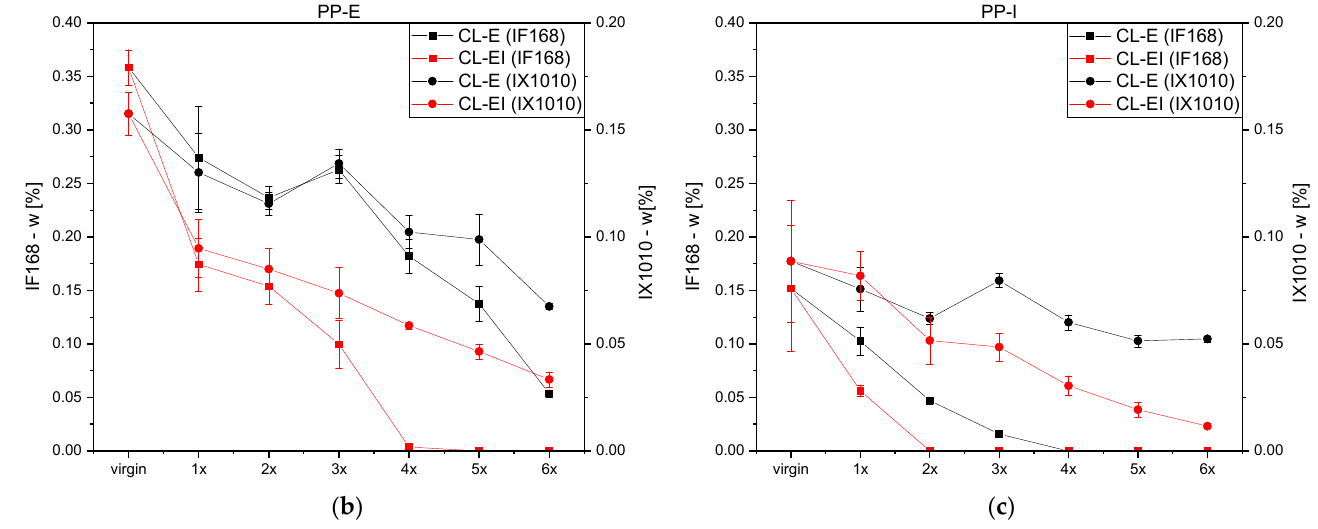
Figure 4. Content of stabilizers IF168 and IX1010 in ( a ) PE-I and both PP grades ( b ) PP-E and ( c ) PP-I after each loop for both recycling cycles.